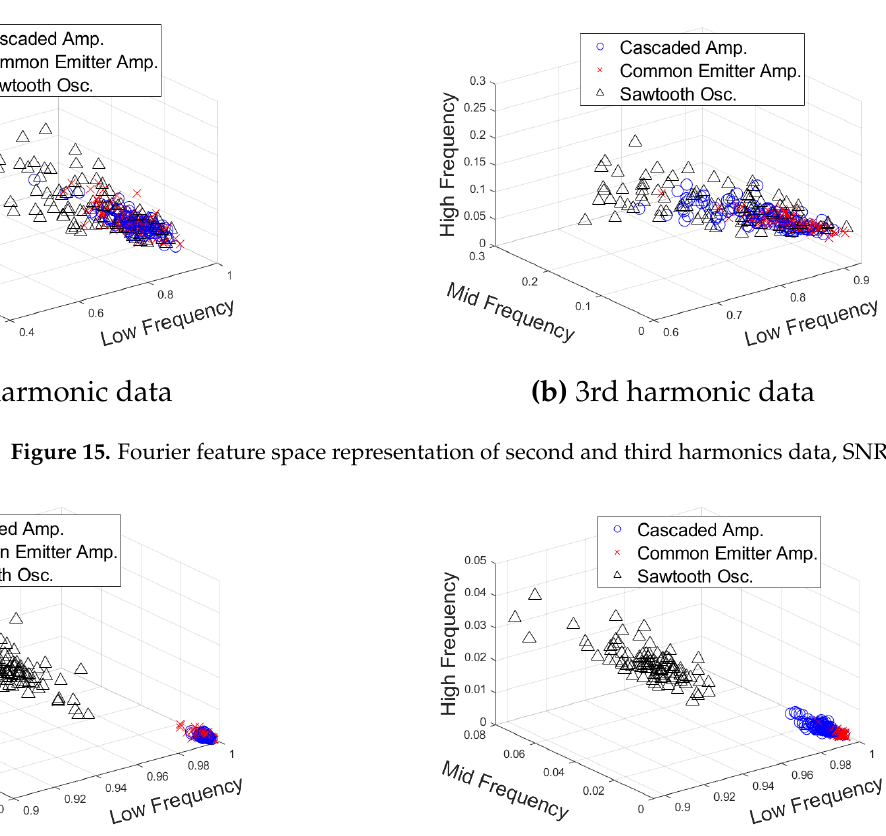
Figure 16. Fourier feature space representation of second and third harmonics data, SNR=14 dB.